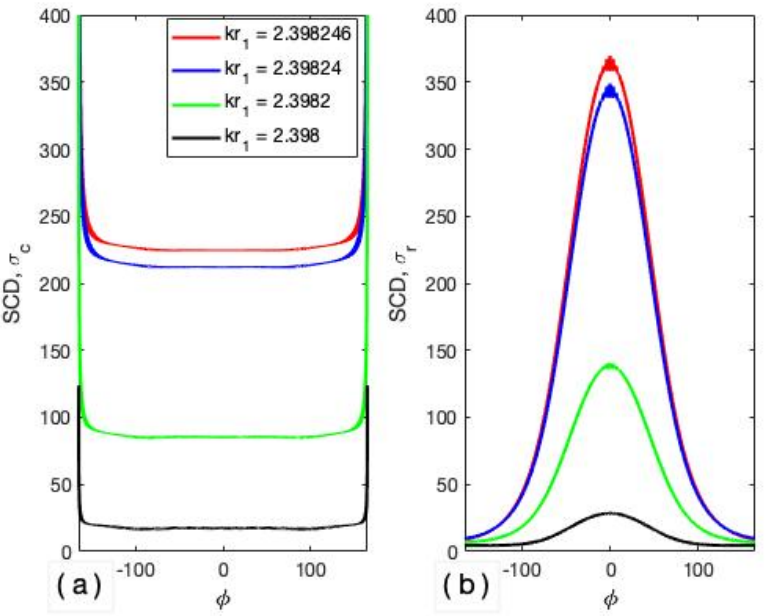
Figure 8. SCDs 𝜎 (cid:3030) (𝜙) and 𝜎 (cid:3045) (𝜙) under excitation of the 𝑇𝑀 (cid:3030)(cid:2868)(cid:2869) complex mode in the cavity–rod system ( 𝑟 (cid:2870) 𝑟 (cid:2869) ⁄ = 0.1 , 𝑥 (cid:2868) 𝑟 (cid:2869) ⁄ = −1.101 , and 𝑤 𝑟 (cid:2869) ⁄ = 2sin𝜋 12⁄ ≈ 0.5176 ): ( a ) cavity; ( b ) rod. system ( r 2 / r 1 = 0.1, x 0 / r 1 = − 1.101, and w / r 1 = 2sin π /12 ≈ 0.5176): ( a ) cavity; ( b )